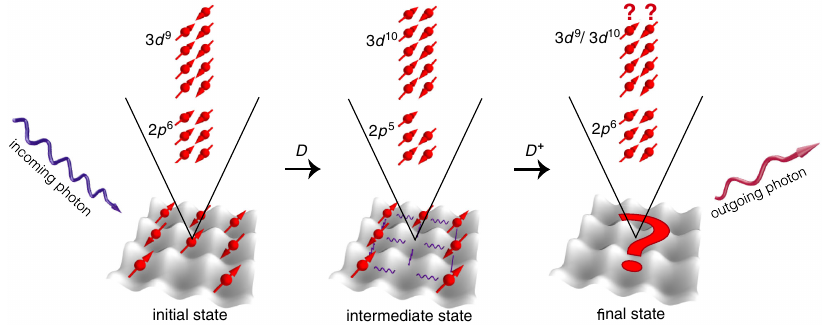
FIG. 1. A schematic that illustrates the RIXS process at the Cu L -edge appropriate for